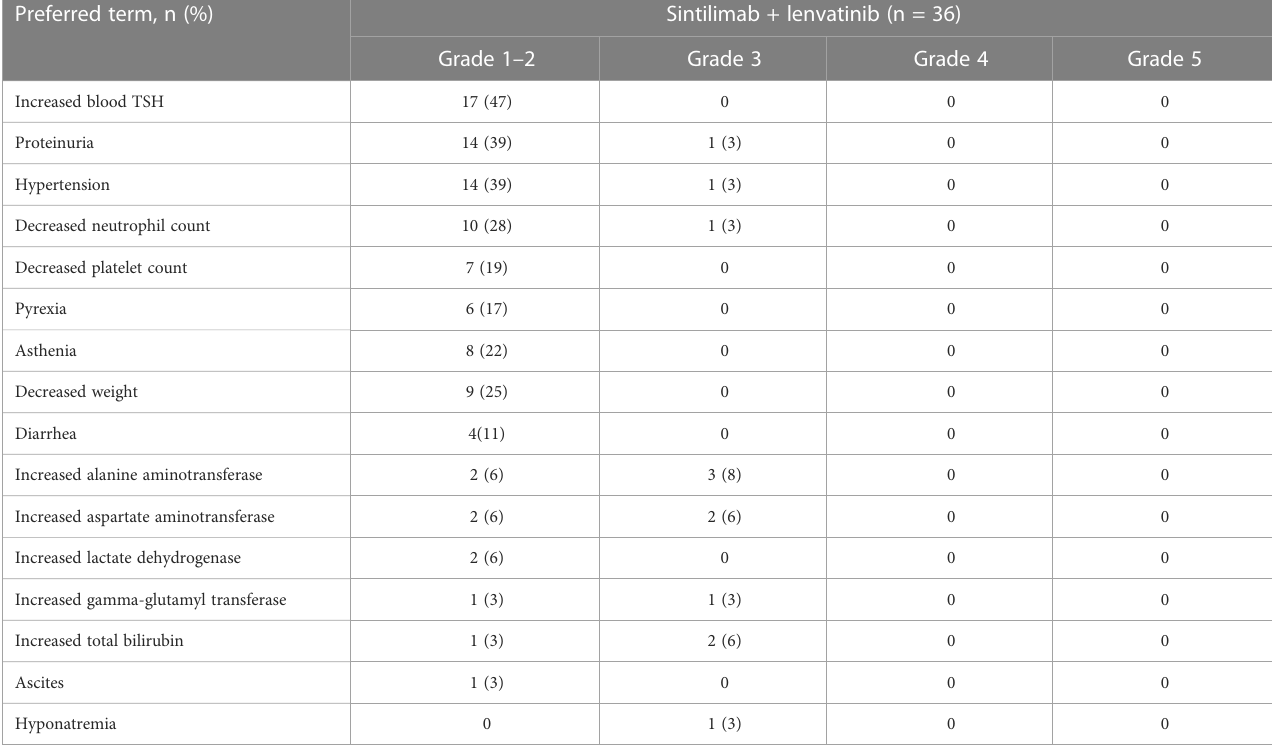
TABLE 2 Most Common Treatment-related Adverse Events.